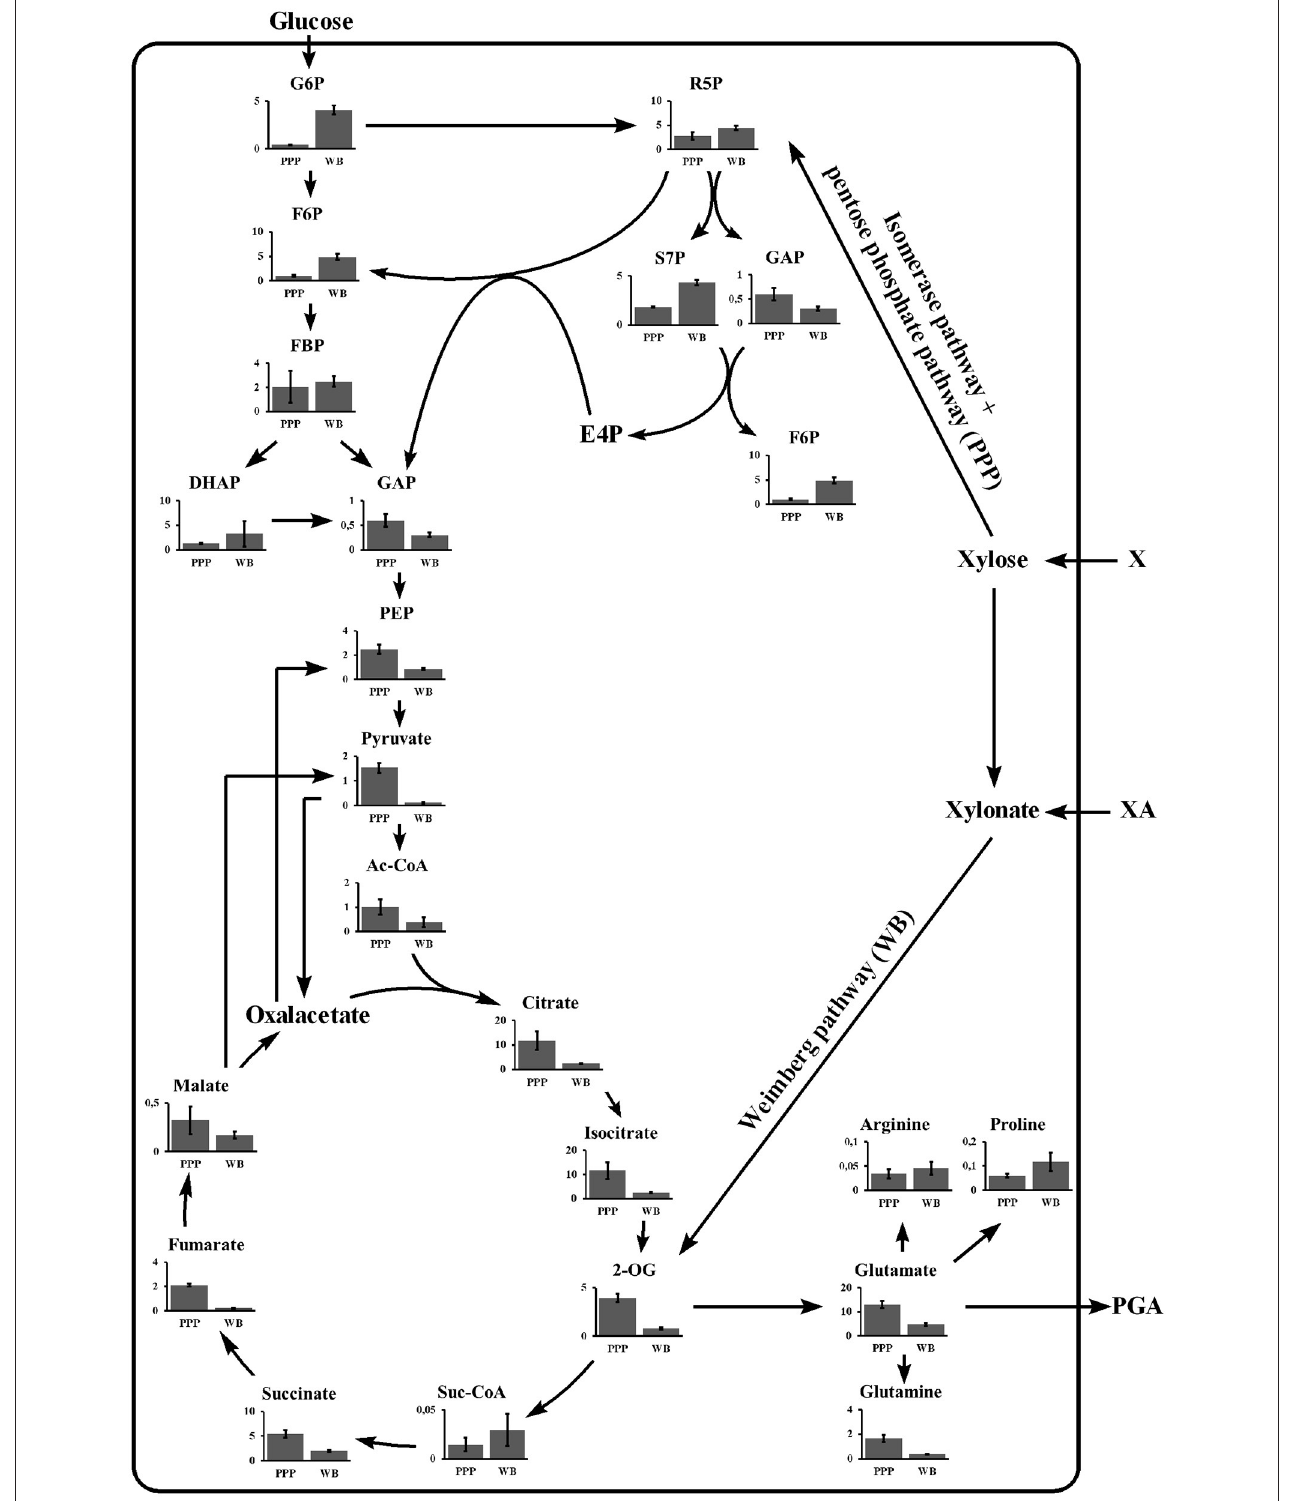
FIGURE 3 | Intracellular metabolite analysis for B. subtilis WB and B. subtilis 1 spo growing on xylose. The metabolite concentrations for glycolysis, PPP, TCA cycle, and glutamate derived amino acids are given for B. subtilis 1 spo (PPP) and B. subtilis WB (WB). Cultivations were carried out in triplicates. The bar graphs represent the mean. The error bar indicates the standard deviation. 2OG, 2-oxoglutarate; DHAP, dihydroxyacetone phosphate; F6P, fructose-6-phosphate; FBP, fructose-bisphosphate; G6P, glucose-6-phosphate; GAP, D -glyceraldehyde 3-phosphate; R5P, ribose-5-phosphate; S7P, sedoheptulose-7-phosphate.